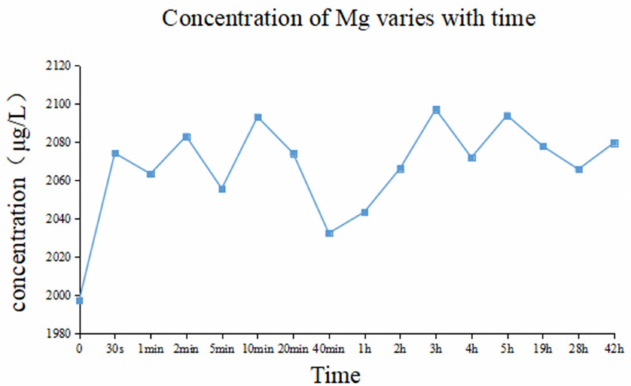
Figure 10. In conventional treatment water the effects of suspended particulate matter at different time adsorption and release of Al, Mn and Ca ( a ); V ( b ).